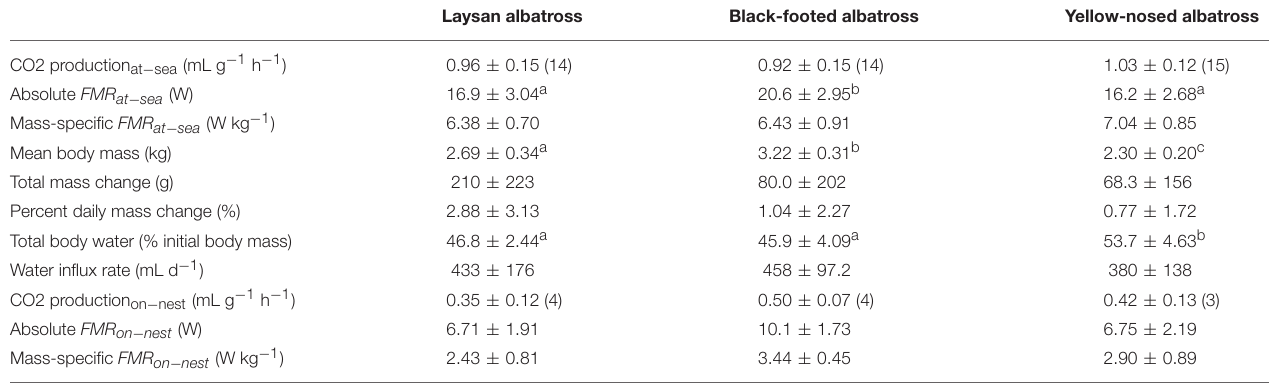
TABLE 3 | Energy expenditure (Mean ± SD ) of Laysan and black-footed albatrosses breeding at Tern Island, Northwest Hawaiian Islands, and Indian yellow-nosed albatrosses breeding at Amsterdam Island, southern Indian Ocean, during the brooding